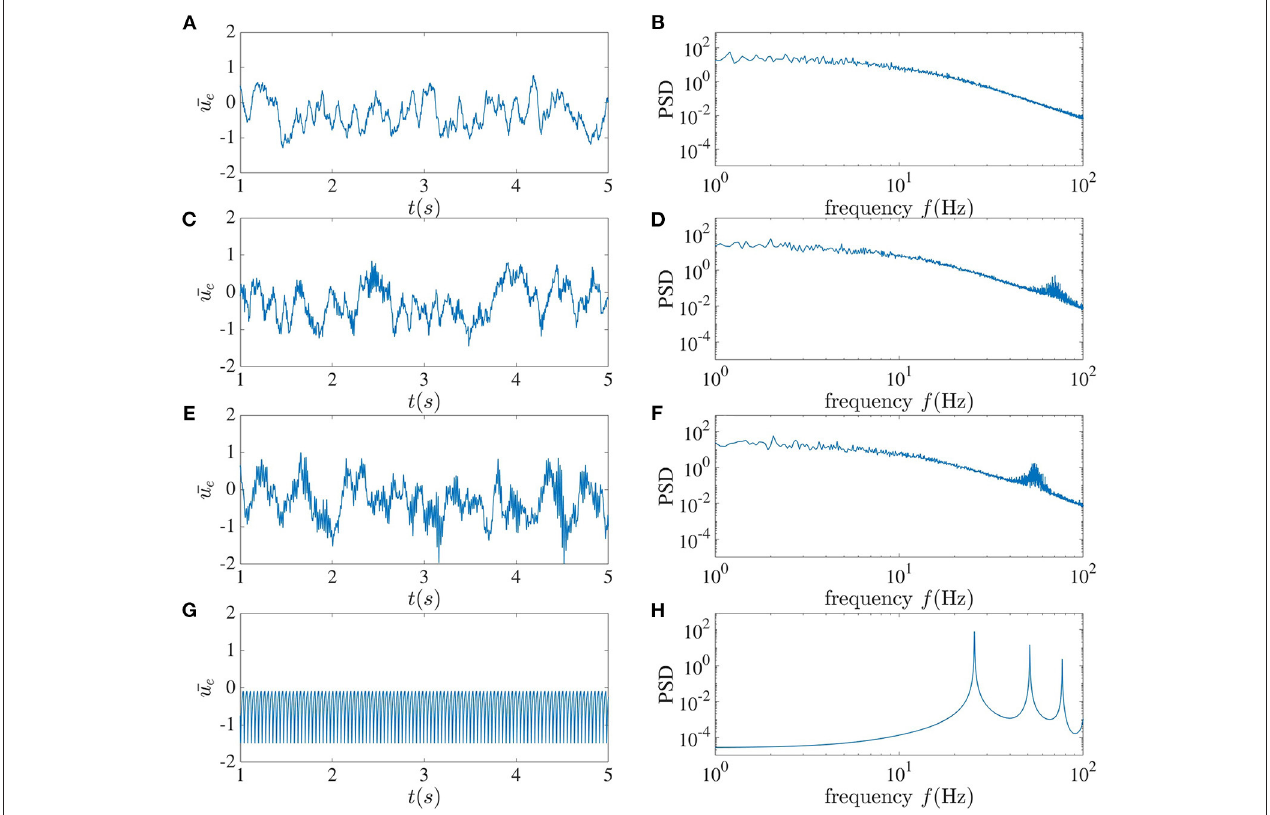
FIGURE 3 | Local dynamics alone. The left column shows the mean activity of the excitatory sub-network, and the right column plots the corresponding power spectrum averaged over the activities in this sub-network. From top to bottom, the local time delay corresponds to (A,B) 2 ms, (C,D) 5 ms, (E,F) 7 ms, and (G,H) 10